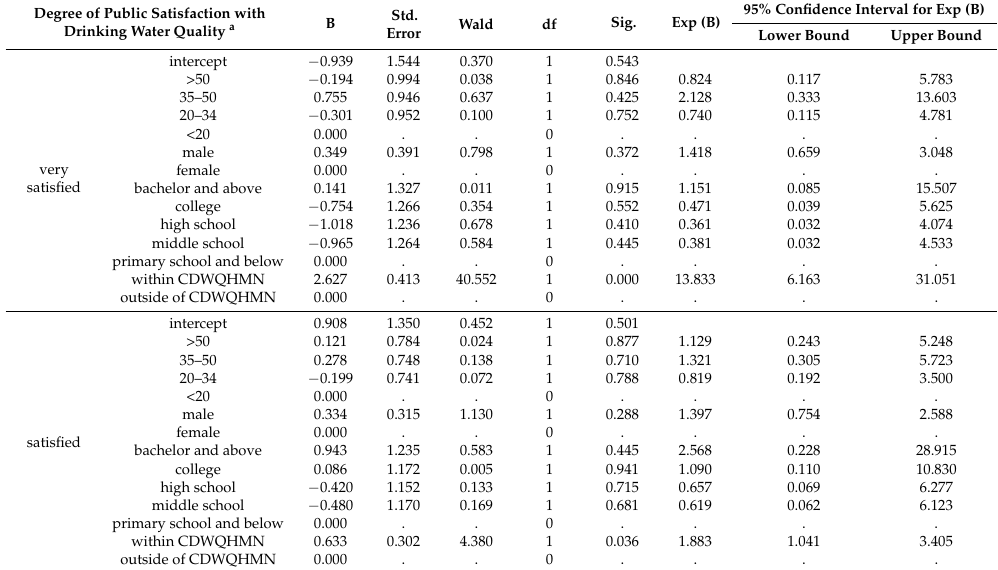
Table 4. Results of multinomial logistic regression analysis for degree of public satisfaction with drinking water quality and its influencing factors.